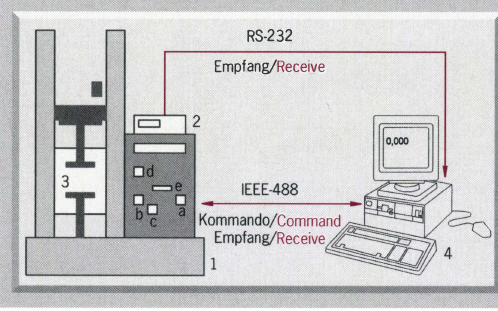
Fig. l: Stress/strain curves of two cheese samples and strain ratejstrain